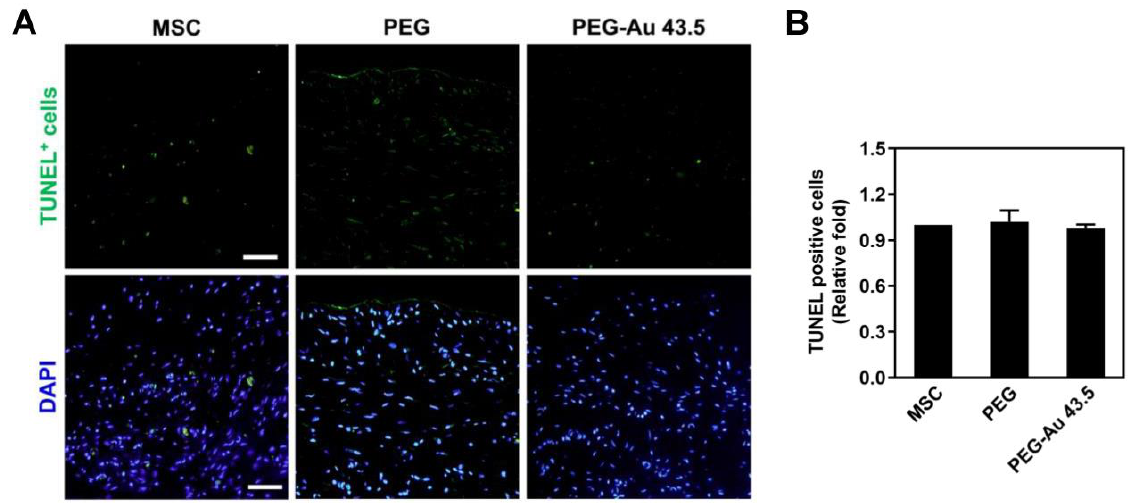
Figure 7. The later stage of cell apoptosis investigated by TUNEL assay after subcutaneous implantation. ( A ) During the later stage of cell apoptosis, DNA will become highly fragmented. It can attach a modified dUTP to the 3′ -OH end of the damaged DNA using the enzyme terminal deoxynucleotidyl transferase dUTP nick end labeling (TUNEL, green color) reaction. ( B ) The semi-quantitative result indicates that there is no significant difference between the treated groups and the control group, while also elucidating PEG – Au 43.5 ppm as a biosafety nanomaterial that does not injure the surrounding tissue in rat models. DAPI was used to locate cell nuclei (blue color). The fluorescence was detected by a confocal microscope. Scale bar = 50 μm. The number of rats was 5 (n = 5). Data are presented as mean ± SD.